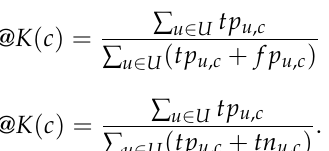
the range of distance k when sampling the number of negative samples m